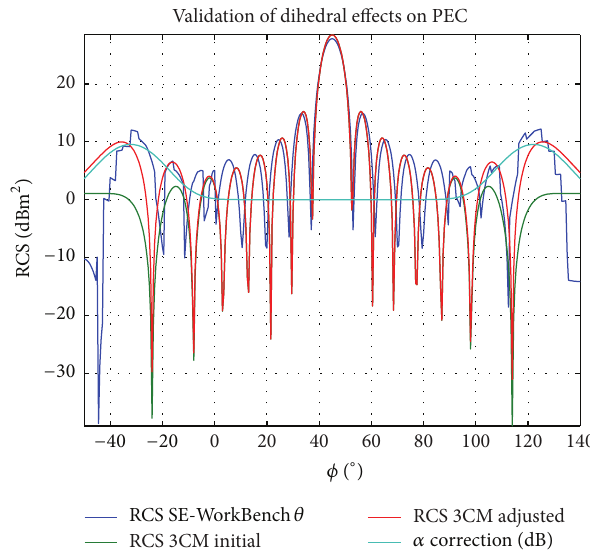
Figure 8: Validation example of the backscattering component